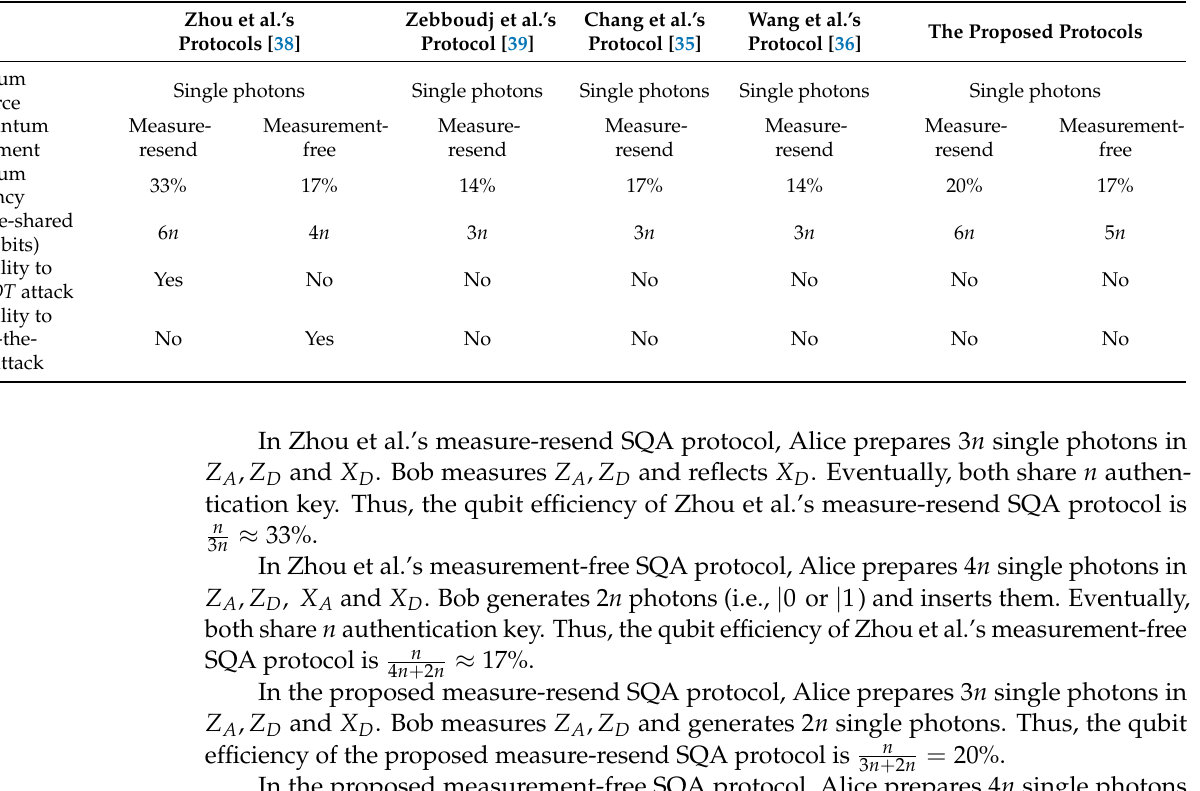
Table 3. Comparison of [35,36,38,39] and the proposed SQA